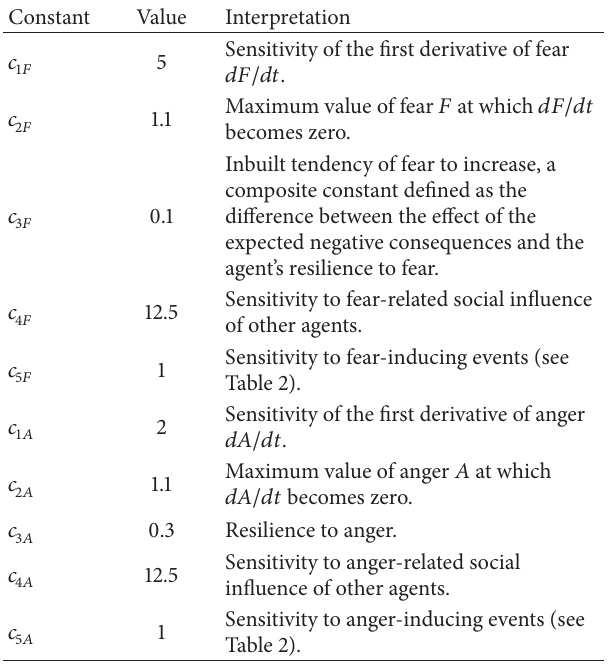
Table 1: Fear- and anger-related